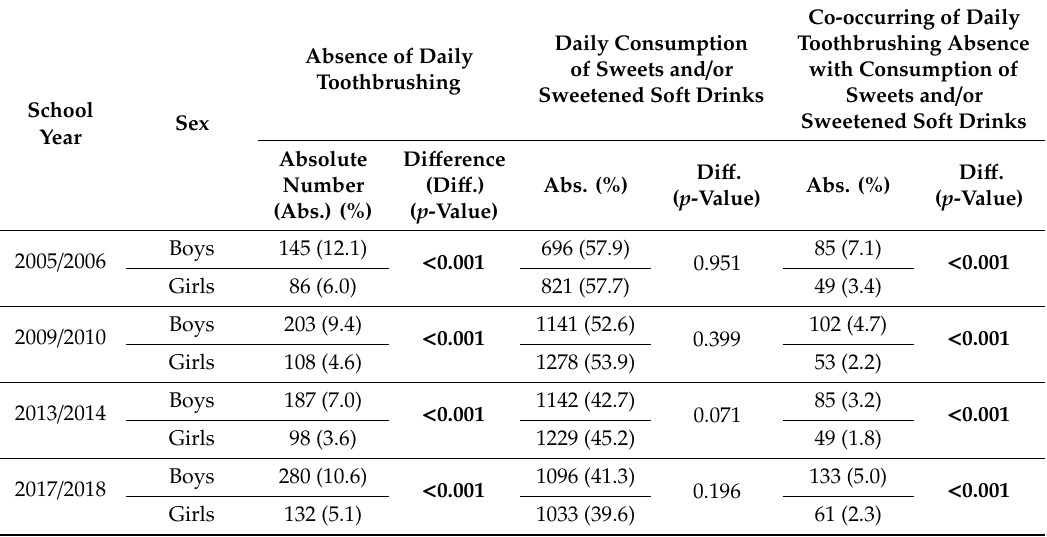
Table 2. Prevalence of the selected behavioural risk factors of dental caries in 11–13 year-old children by sex.